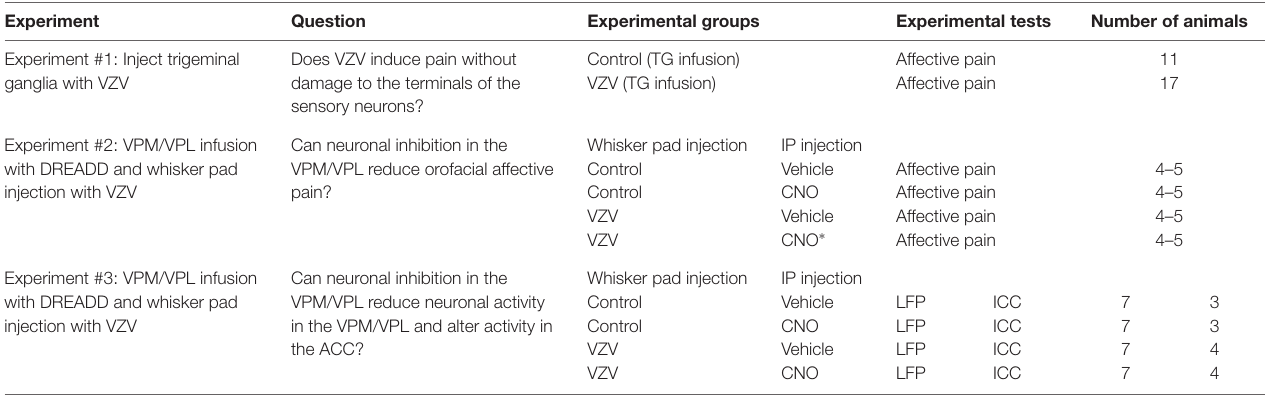
TABLE 1 | Experimental outline for testing VZV